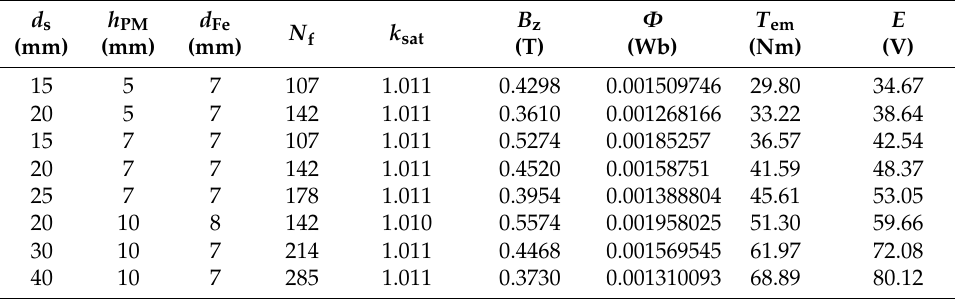
Table 3. Design of 10 pole AFPMSM using an analytical